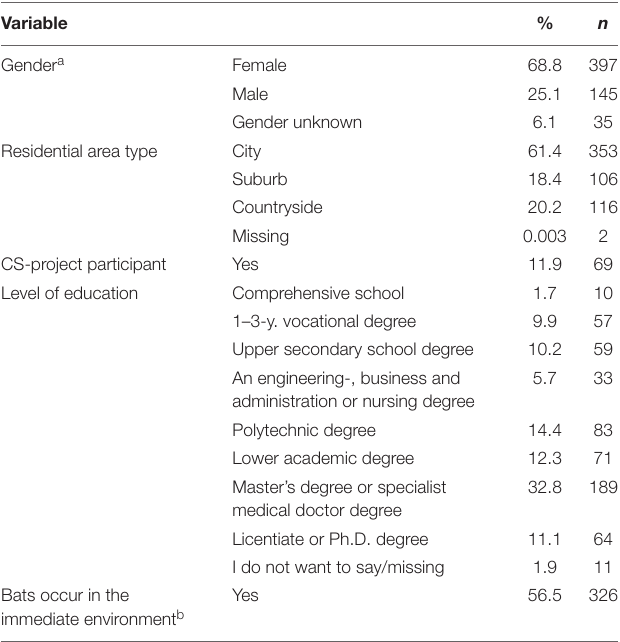
TABLE 1 | Sociodemographic background of the respondents ( n = 577) and prior experiences with bats.